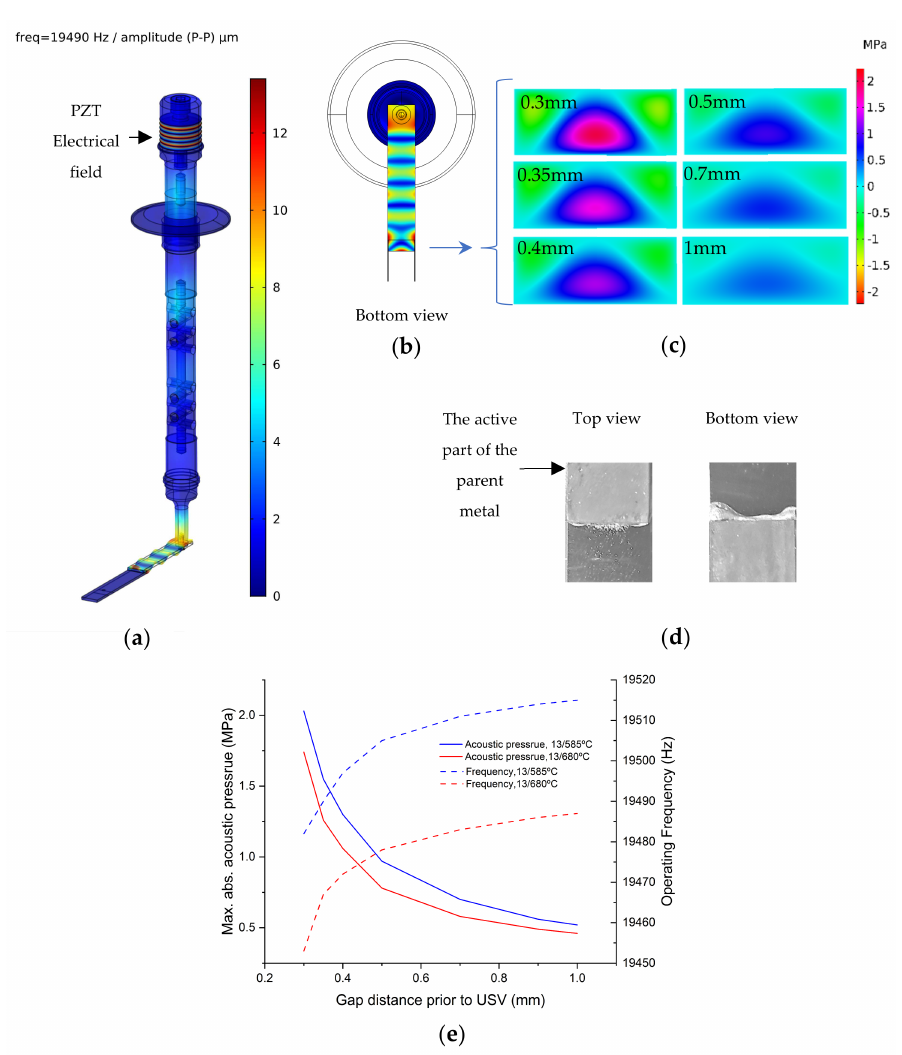
Figure 9. ( a ) The displacement obtained for the system during brazing process (0.35 mm thickness of the filler Al-13Si at 585 ◦ C); ( b ) Bottom view of the active part of the parent metal with the same scale legend of (a); ( c ) The acoustic pressure distribution at brazing temperature 585 ◦ C in the filler of different thicknesses—bottom view; ( d ) Typical joint of Al-13Si brazed at 585 ◦ C, confirming the filler behavior according to the vibration mode and acoustic pressure distribution; ( e ) Filler thickness (gap distance) vs acoustic pressure and operating frequency ( ± 3 Hz ) at 680 and 585 ◦ C brazing